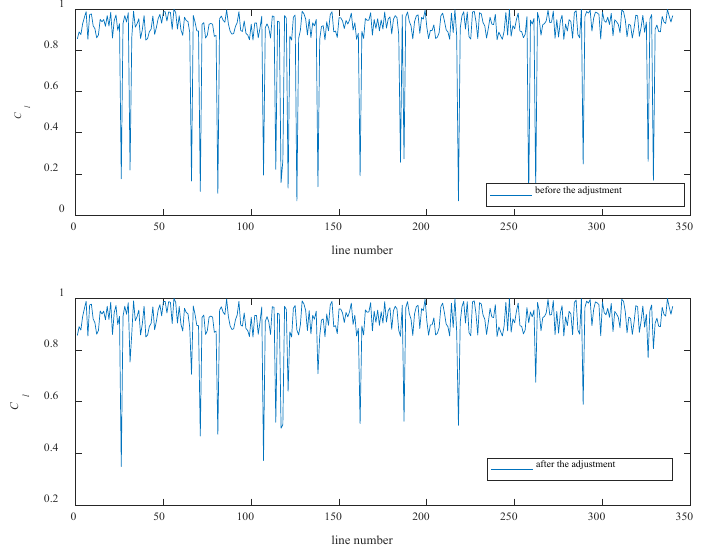
Figure 10. Line transmission metric before and after adjustment in Case 2.